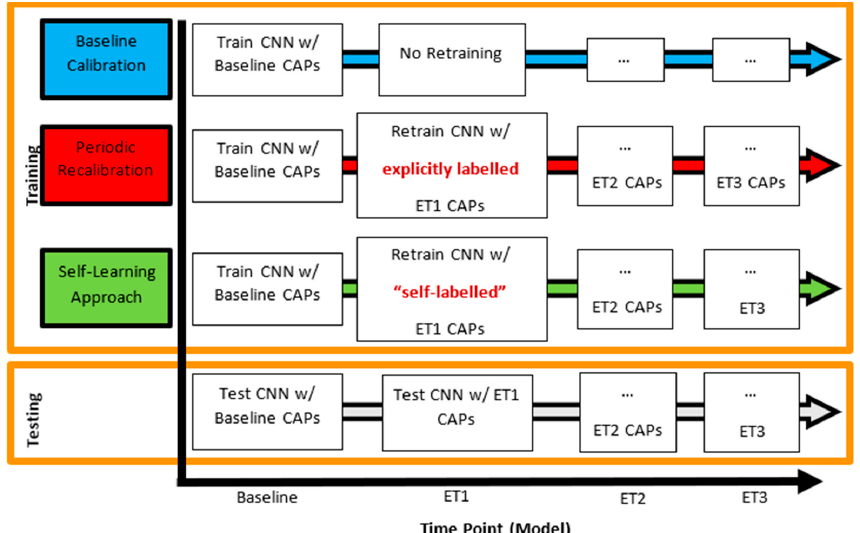
Figure 6. Training and testing scenarios of the three updating approaches. The vertical axis of the strategy, while the horizontal axis represents time elapsing and subsequent changes in the interface. Text boxes within the figure show training and testing approaches corresponding to specific update strategies at a given time point (in this case representing the growth of encapsulation